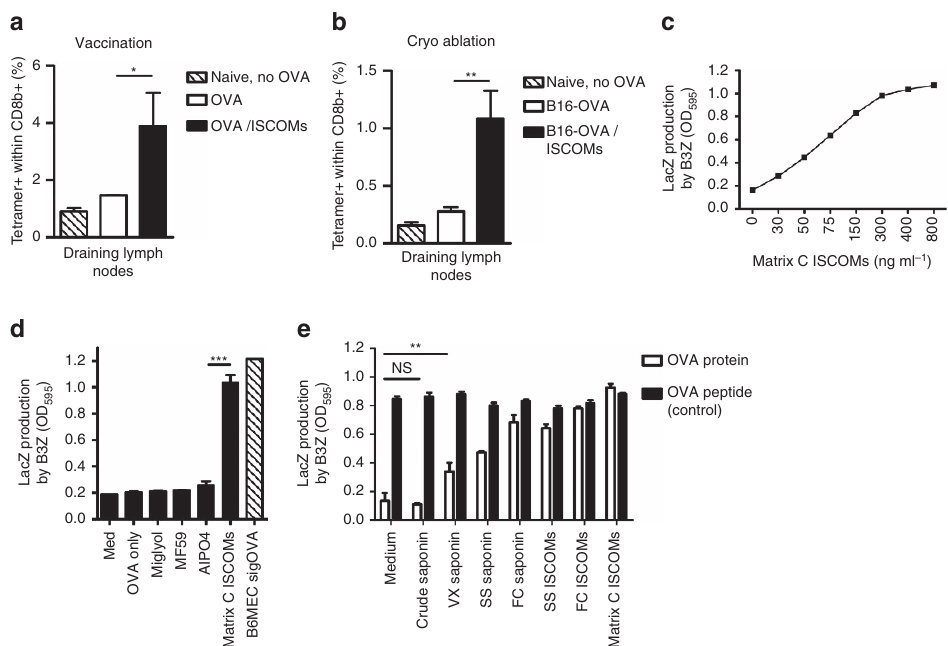
Figure 1 | Saponin-based adjuvants induce cross-presentation in dendritic cells. ( a , b ) Tetramer staining of OVA specific Tcells in draining lymph nodes, 10 days following s.c. injection of 20 m g OVA and/or 30 m g ISCOMs ( a , vaccination), or 7 days following co-treatment of established B16OVA melanomas (5–8mm diameter) with in situ tumour ablation and 30 m g peritumourally injected ISCOMs ( b , Cryo-ablation). ( c , d ) In vitro B3Z cross-presentation assays demonstrating a concentration-dependent increase in cross-presentation of OVA, only when Matrix C ISCOMs was added. GM-CSF-cultured BMDCs were exposed to the indicated compounds and 80 m gml (cid:2) 1 OVA protein for 5h, washed and co-cultured o/n with B3Z cells, which produce b -galactosidase upon recognition of the OVA peptide in K b . Data in ( d ) are excerpts from larger titrations. For the non-reactive adjuvants the maximum concentration used is shown (1.5 m lml (cid:2) 1 ), for the ISCOMs the concentration shown is 400ngml (cid:2) 1 . ( e ) In vitro cross-presentation after 5h exposure to 400ngml (cid:2) 1 of various SBAs or controls. This contains a crude saponin mixture not purified for immunoactive fractions, commercially available immunoactive saponin fractions (VX, SS and FC) and ISCOM structures made with these saponins according to an ‘open access’ protocol. Passive peptide loading with OVA K b peptides was used to demonstrate viability and/or equal MHC-I levels. Similar results were obtained in two to three independent experiments. Statistical analysis was done using a one or two-way ANOVA with post hoc Bonferroni or Tukey